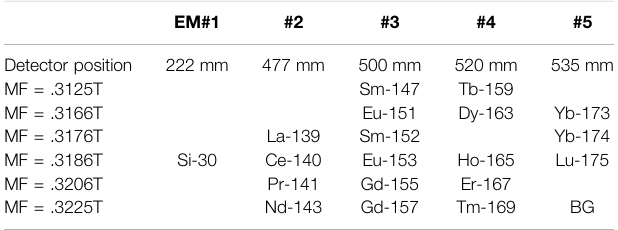
TABLE 1 | A multi-collector system with peak-jumping by magnetic fi eld to detect all rare earth elements (REEs) in silicate glass and zircon EM#1 Detector